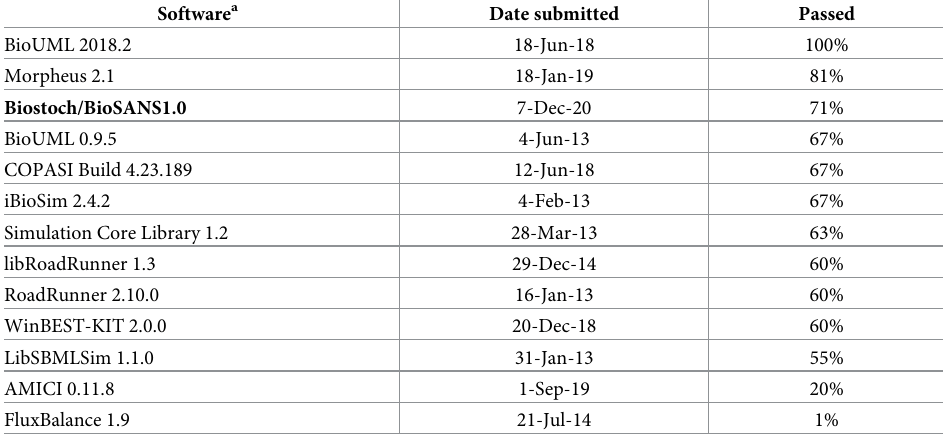
Table 2. Comparison of performance of several software packages for the SBML semantic test